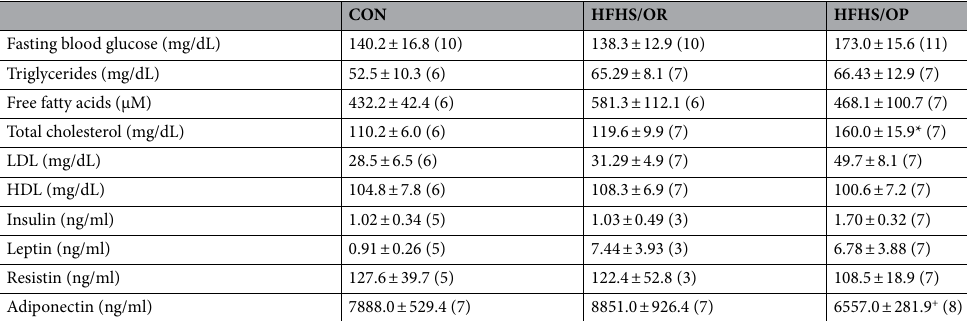
Table 2. Measured plasma glucose, lipids, and hormones measured at 8 weeks postpartum. Values are expressed as mean ± SEM; Parenthesis indicates the sample size. CON, control; HFHS/OR, obese-resistant mice fed a high-fat high-sucrose diet; HFHS/OP, obese-prone mice fed a high-fat, high-sucrose; LDL, low- density lipoprotein; HDL, high-density lipoprotein; * P < 0.05 versus CON, + P < 0.05 versus